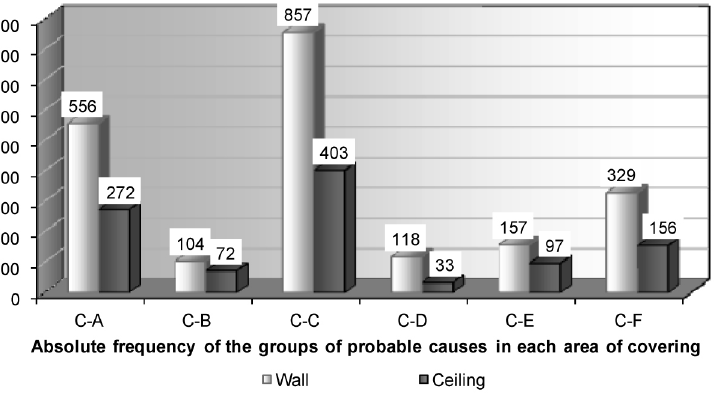
Fig. 8. Absolute frequency of the groups of probable causes in each area of coating: walls or ceilings